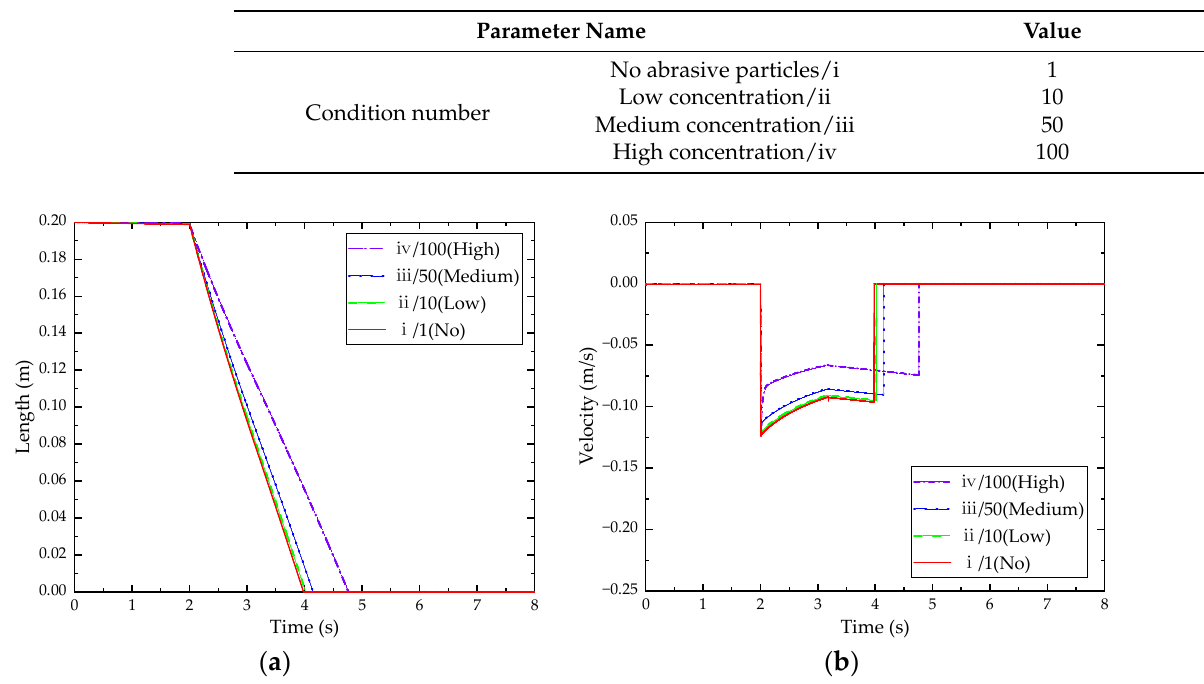
Table 4. Abrasive particle concentration under different working conditions.